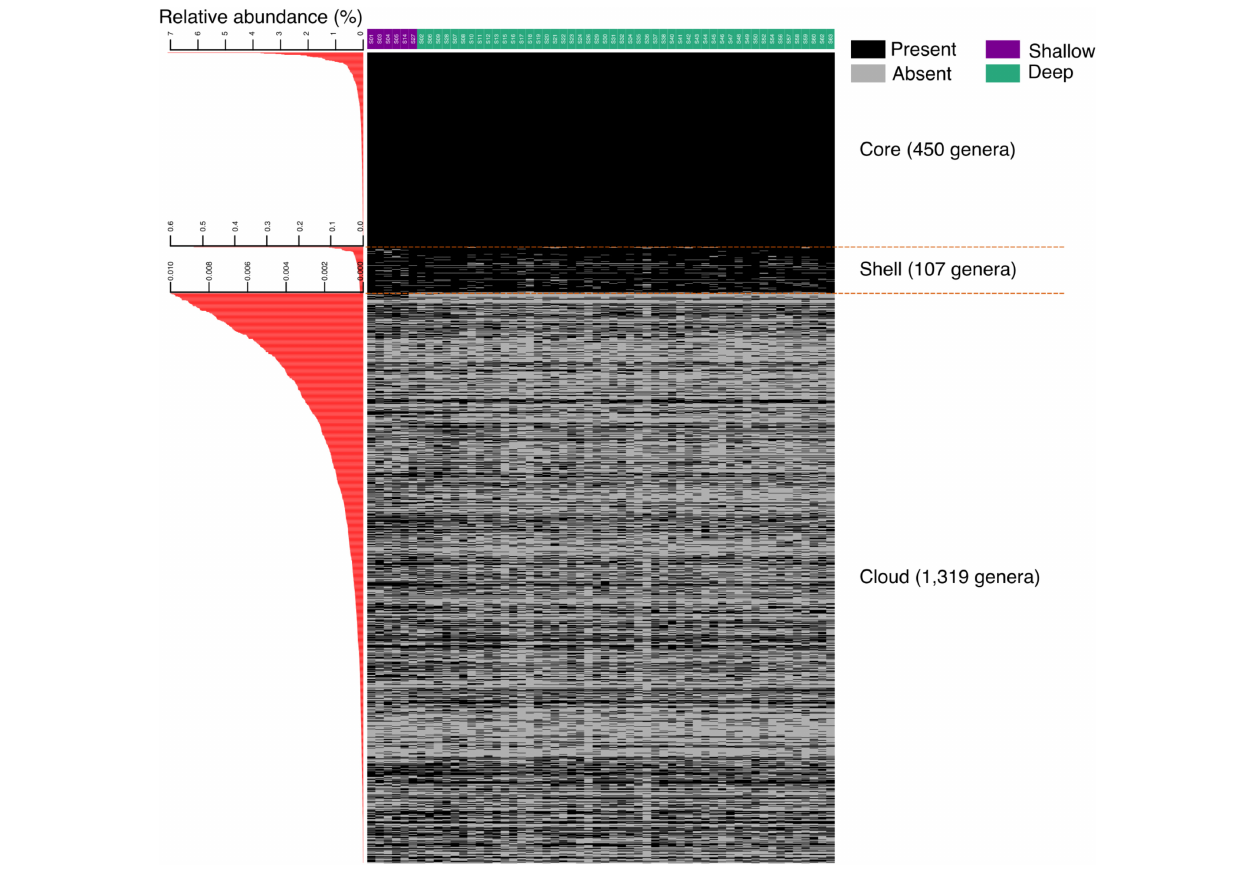
FIGURE 2 | Marine sediment richness in samples from the swGoM. Core, shell and cloud groups were generated at the genus taxonomic level using an absence/presence representation. The “core” corresponds to the genera present in all sites; the “shell” includes the genera with a relative abundance > 0.01% but which are absent in at least one sample; and the “cloud” corresponds to the genera with low relative abundances of < 0.01%. On the left, the average of the relative abundance of each genus is